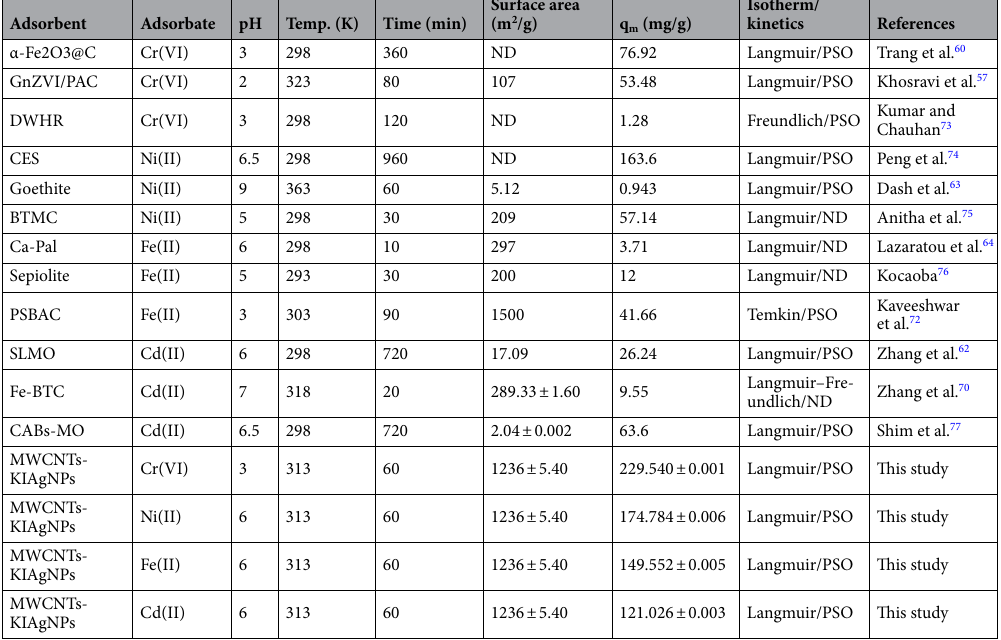
Table 6. Comparison of adsorption parameters among the adsorbates and various adsorbents. PFO pseudo- first order, PSO pseudo-second order, ND not